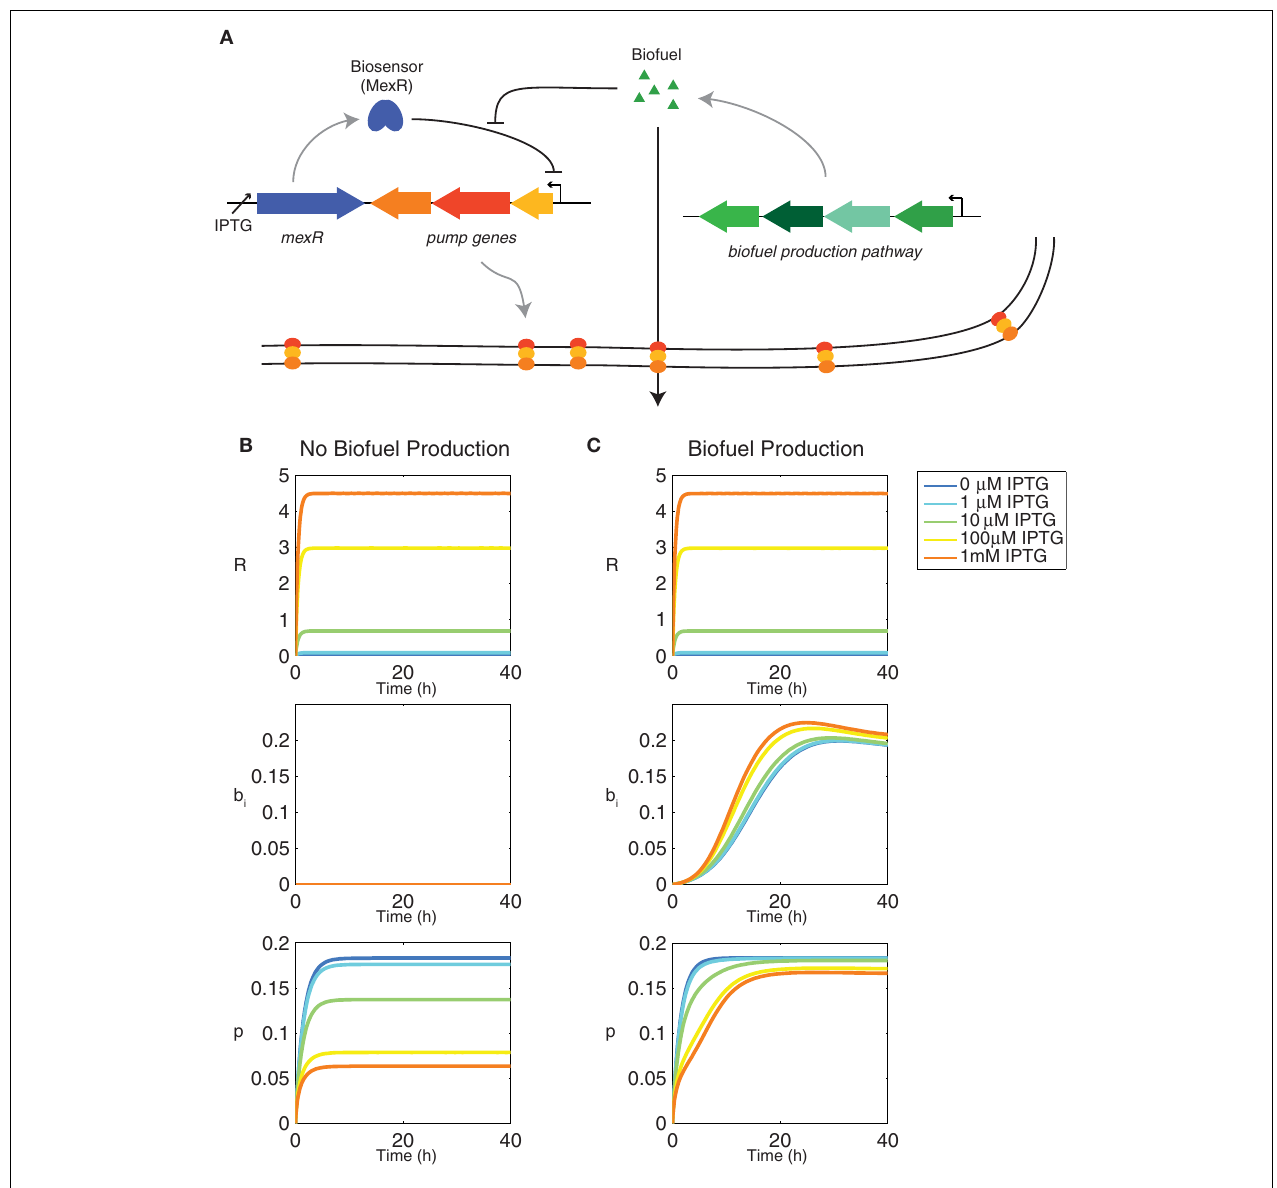
FIGURE 1 | Genetic components of the synthetic feedback loop and dynamics of the biosensor. (A) Gene circuit design for the biosensor and synthetic feedback loop. (B) Transient behavior of the feedback model